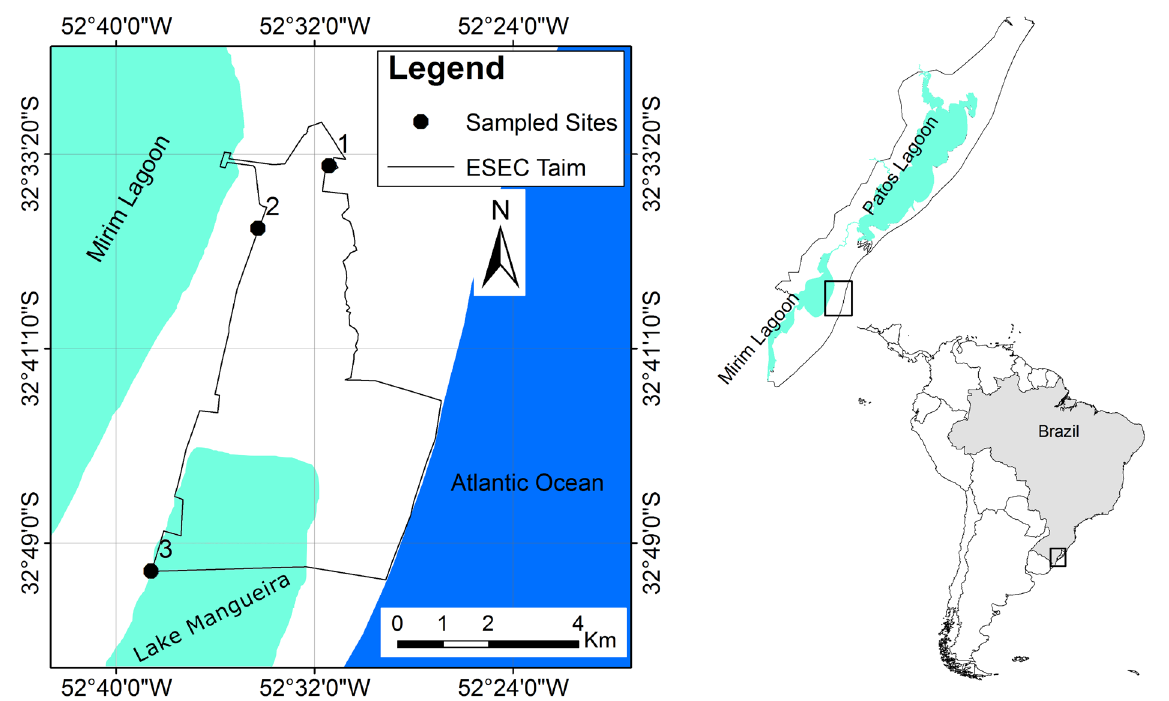
Figure 1. Sampling sites at the Taim nature reserve (ESEC Taim) in the Coastal Plain of southern